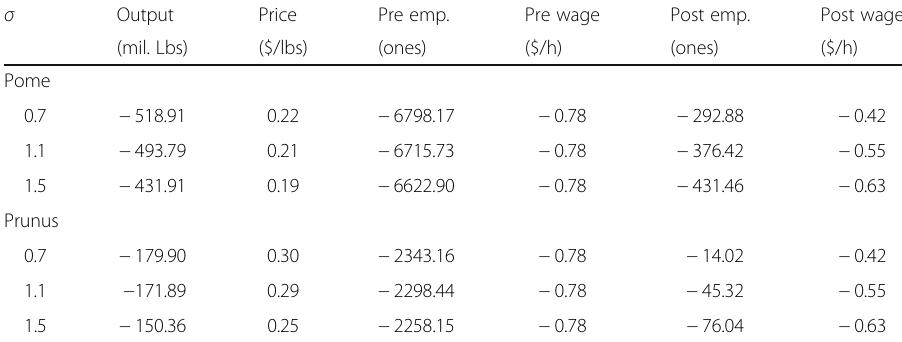
Table 4 Post-shock equilibrium and fixed wage outcome level change σ Output Price Pre emp. Pre wage Post emp. Post wage (mil. Lbs) ($/lbs) (ones) ($/h) (ones) ($/h) Pome 0.7 0.19 − 6622.90 − 0.78 − 431.46 − 0.63